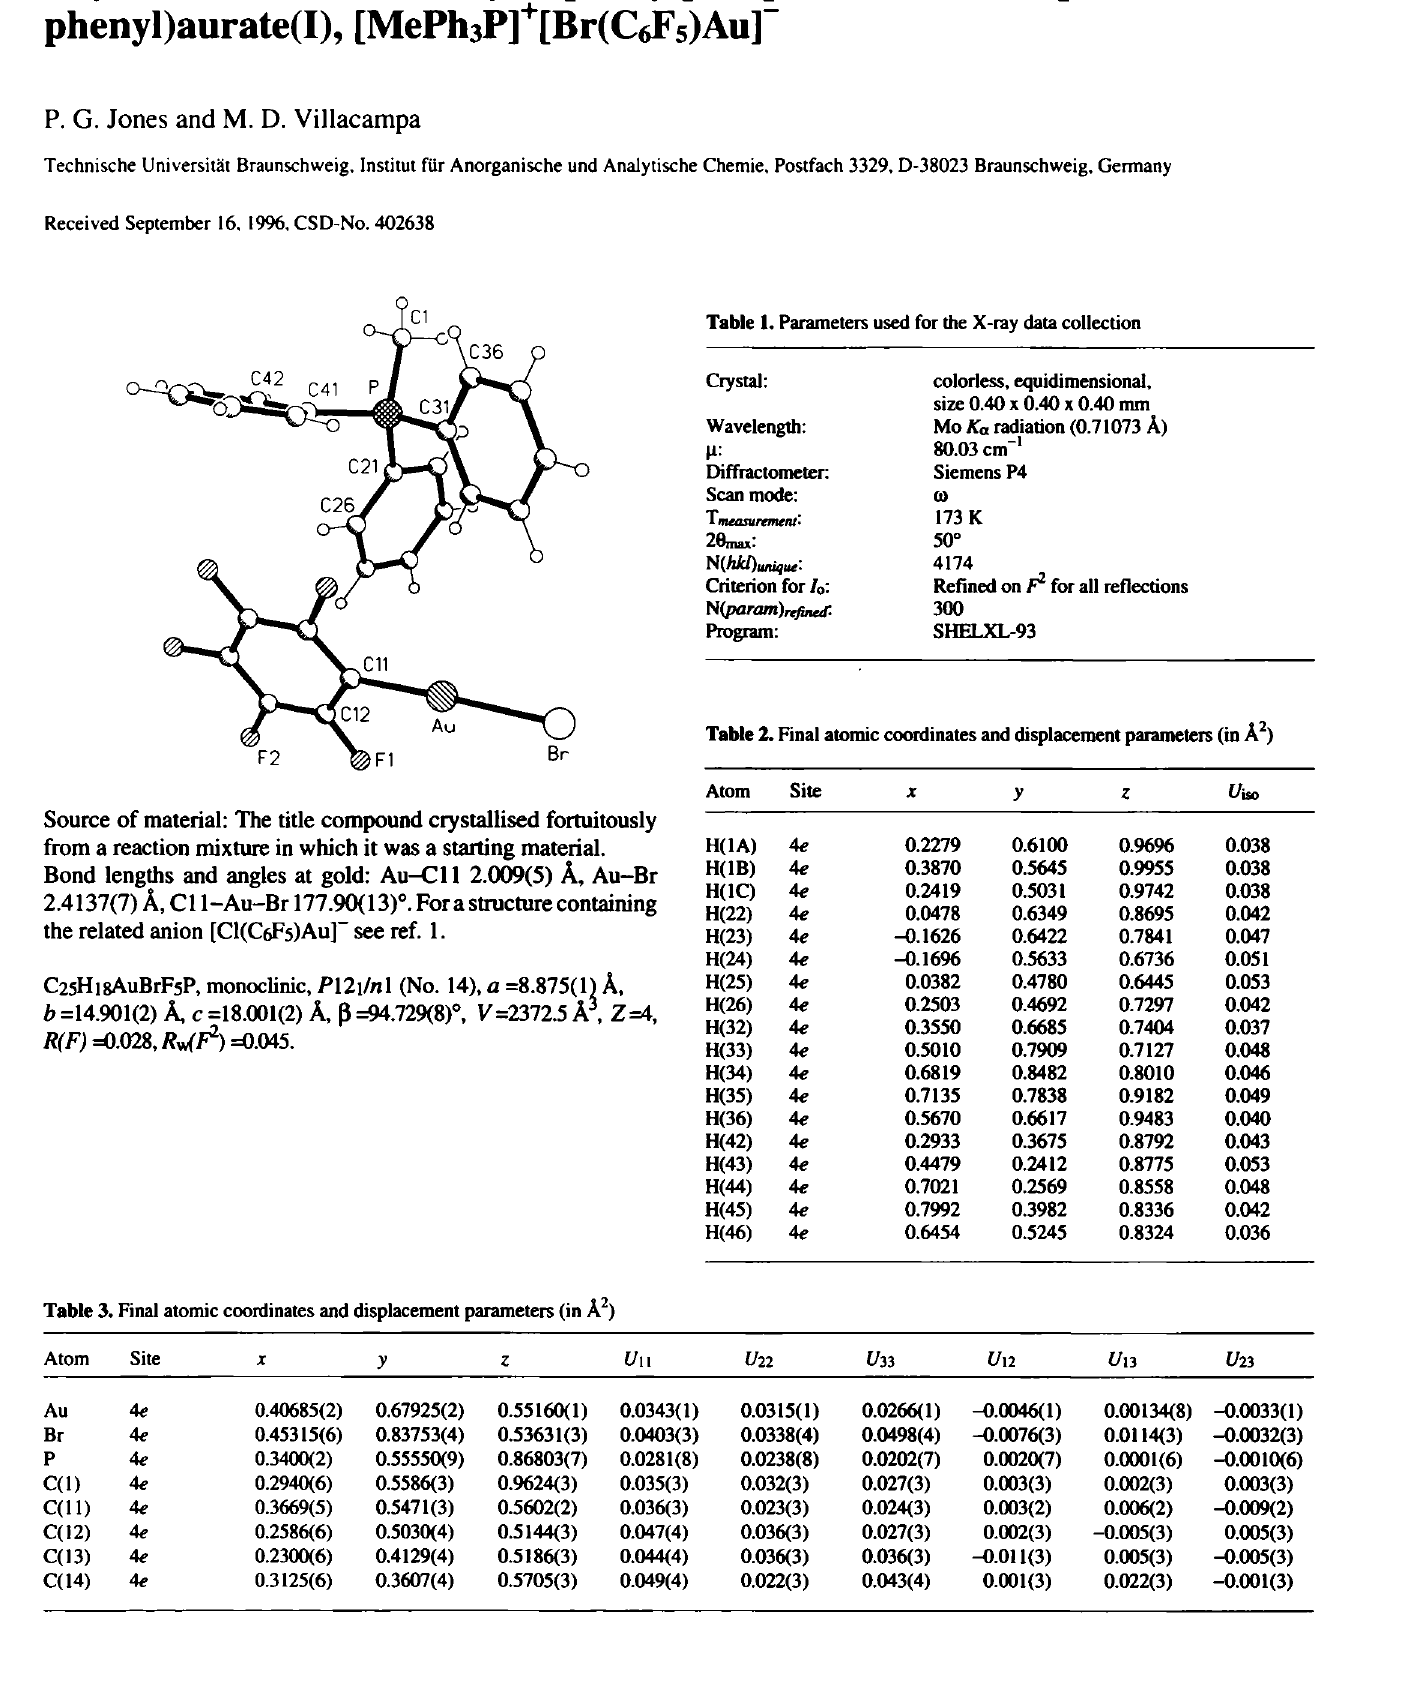
Table 3. Final atomic coordinates and displacement parameters (in Â 2 ) Atom